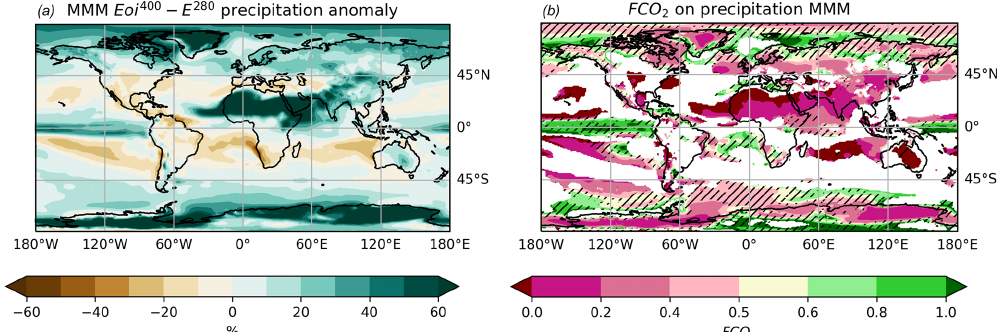
Figure 6. MMM Eoi 400 minus E 280 precipitation anomaly (a) and FCO 2 of MMM for precipitation (b) . In (b) , regions of Eoi 400 –E 280 precipitation change of less than 10% are masked (white), and hatching represents where there is no consistent agreement between models on whether CO 2 forcing or non-CO 2 forcing is the most important (i.e. whether FCO 2 > 0 . 5 or FCO 2 < 0 .